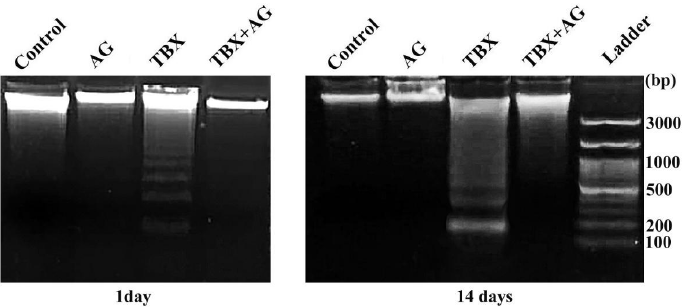
Figure 2. The protective effect of AG against TBX-induced alterations in oxidative stress markers after 1 and 14 days of treatments. ( A ) MDA: malondialdehyde, ( B ) NO: nitric oxide, ( C ) CAT: catalase and ( D ) GSH: glutathione. *: Significant ( p < 0.001) relative to untreated groups. #: Significant ( p < 0.001) relative to TBX-treated groups. Data were represented as mean ± SE of three independent experiments ( n = 5). AG: 10% Arabic gum, TBX: Telebrix (1600 mg I/kg b.wt.) and TBX+AG: co-treatment with 1600 mg/kg b.wt. and 10% Arabic gum.